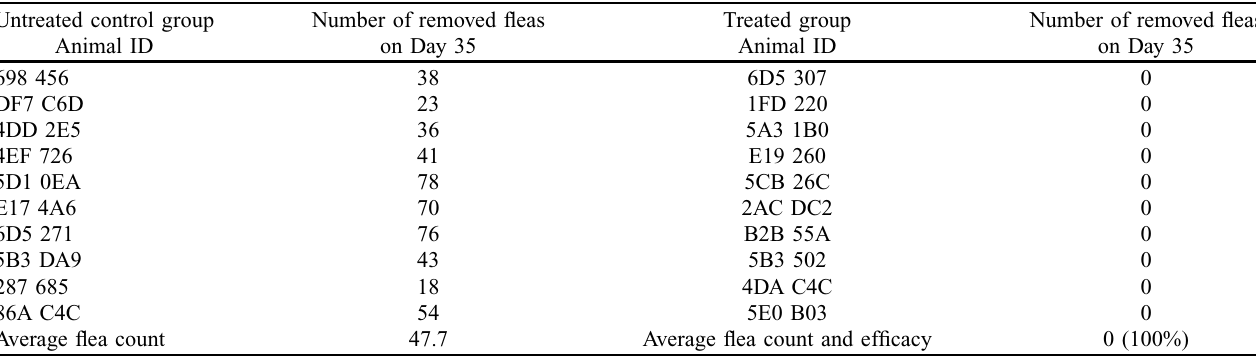
Table 5. Fleas recovered from the control and treated dogs on Day 35.